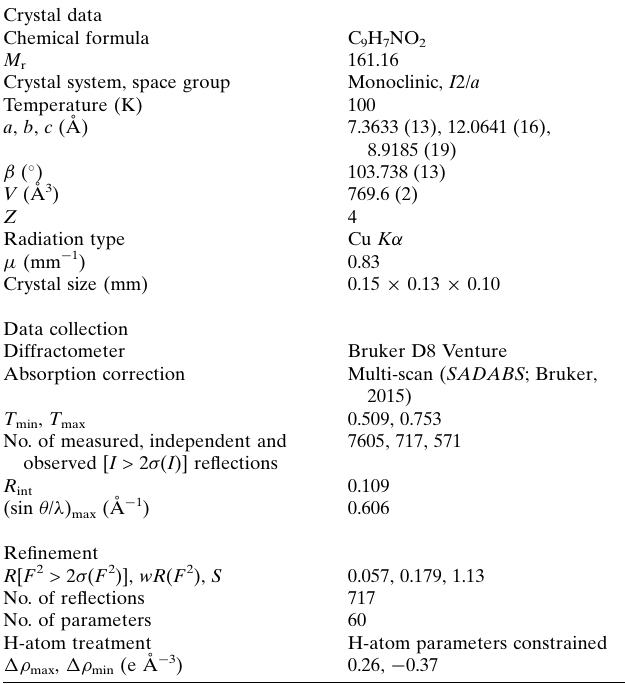
Table 1 Experimental details. Crystal data Chemical formula